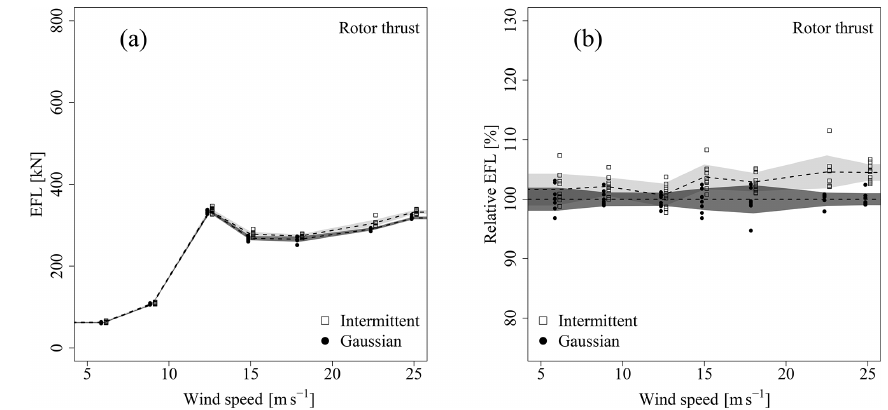
Figure 11. EFL for the rotor thrust for a subdivided 3 × 3 field. The figure is analogous to Fig. 7.